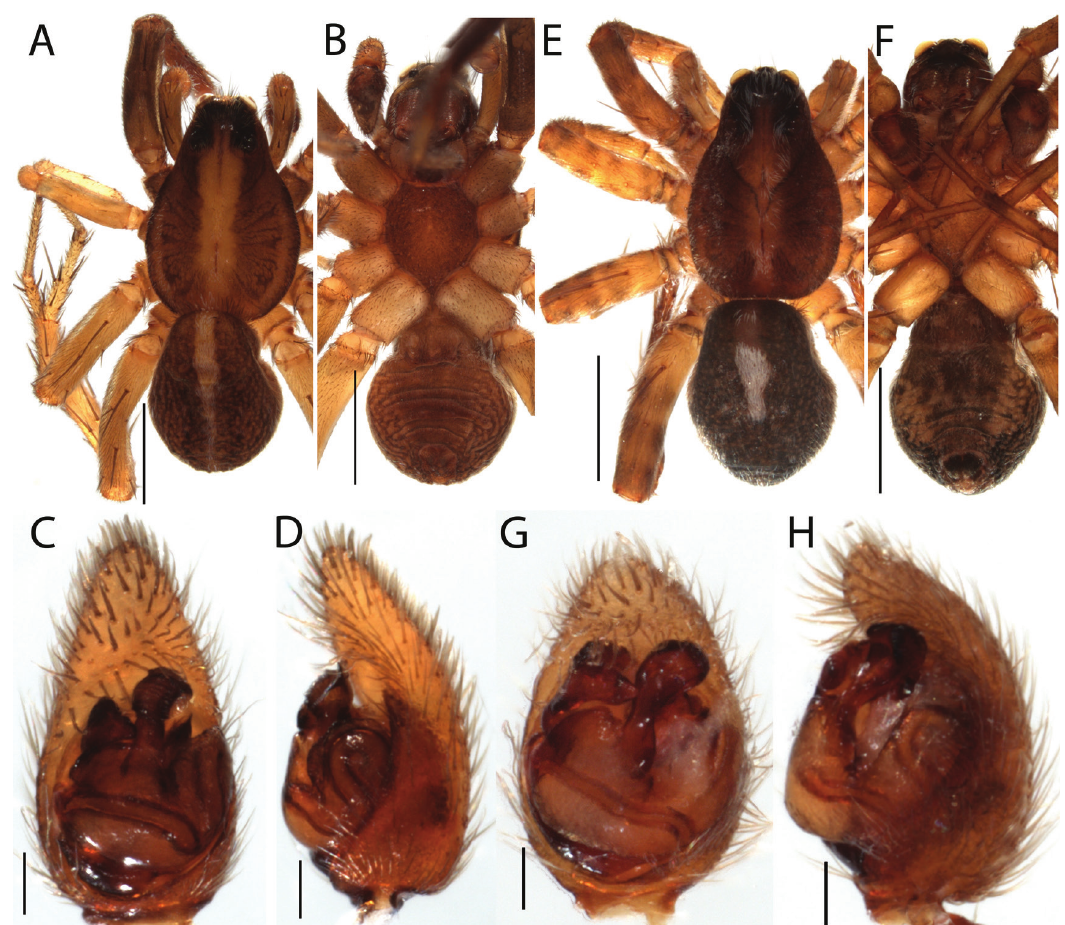
Figure 6. A–D , Artoria barringtonensis sp. n., male holotype (AM KS122794), E–H , Artoria bondi sp. n., male holotype (AM KS128073): A , habitus, dorsal view; B , habitus, ventral view; C , pedipalp, ventral view; D , pedipalp, retrolateral view; E , habitus, dorsal view; F , habitus, ventral view; G , pedipalp, ventral view; H , pedipalp, retrolateral view. Scale bars: habitus 1.0 mm; pedipalp 0.1